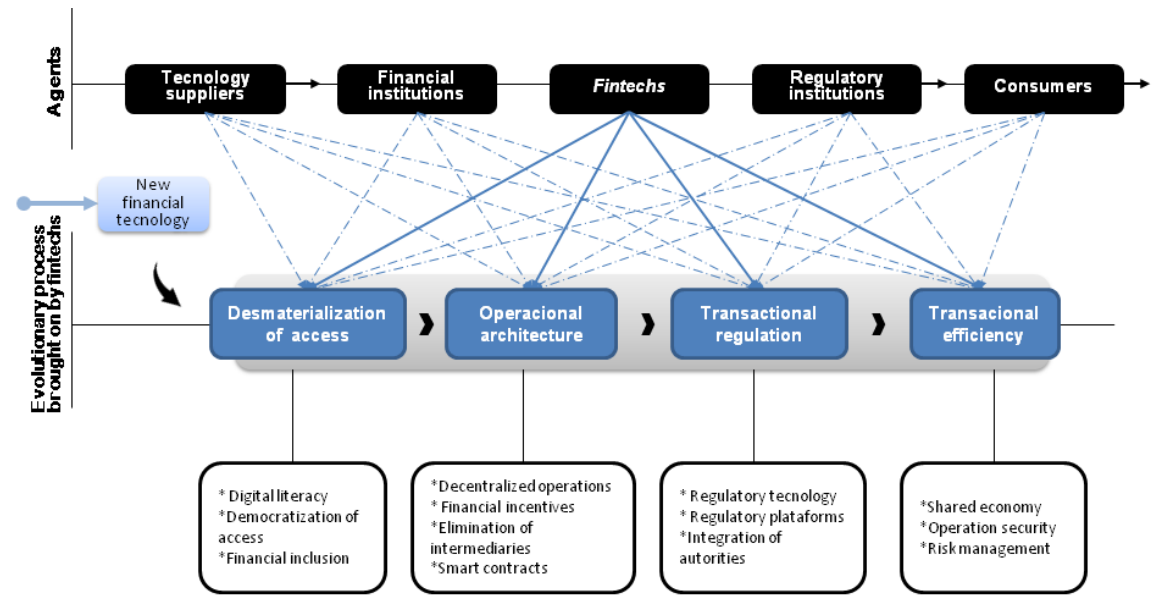
Figure 4. Framework regarding institutions and fintech market agents. Source: the authors.